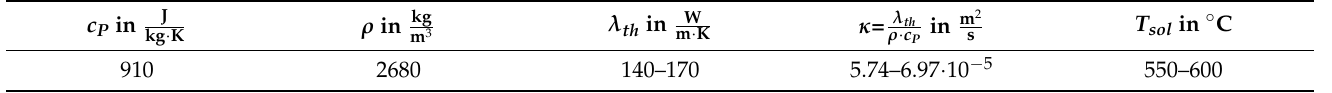
Table 1. Material properties used for AlSi10Mg